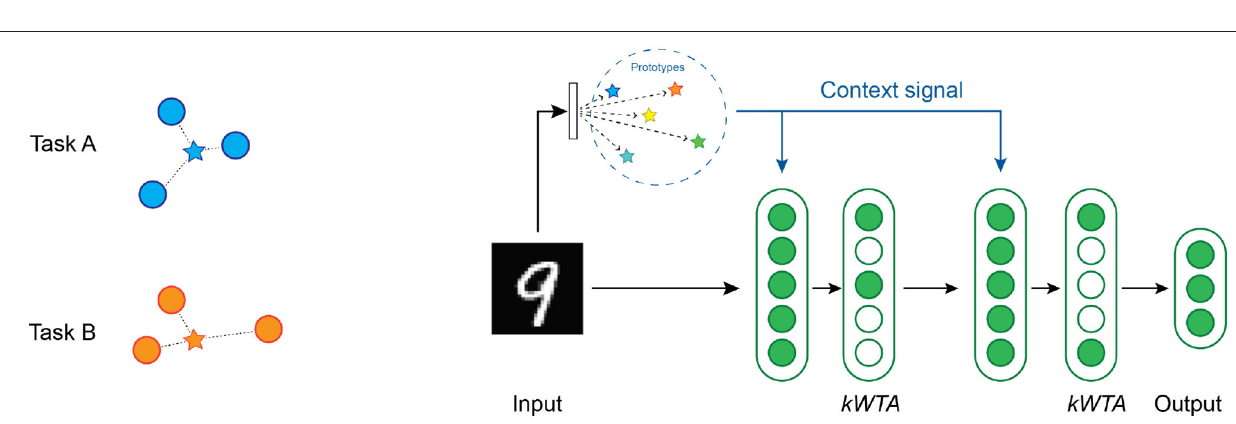
correspond to a new task, and a novel prototype is